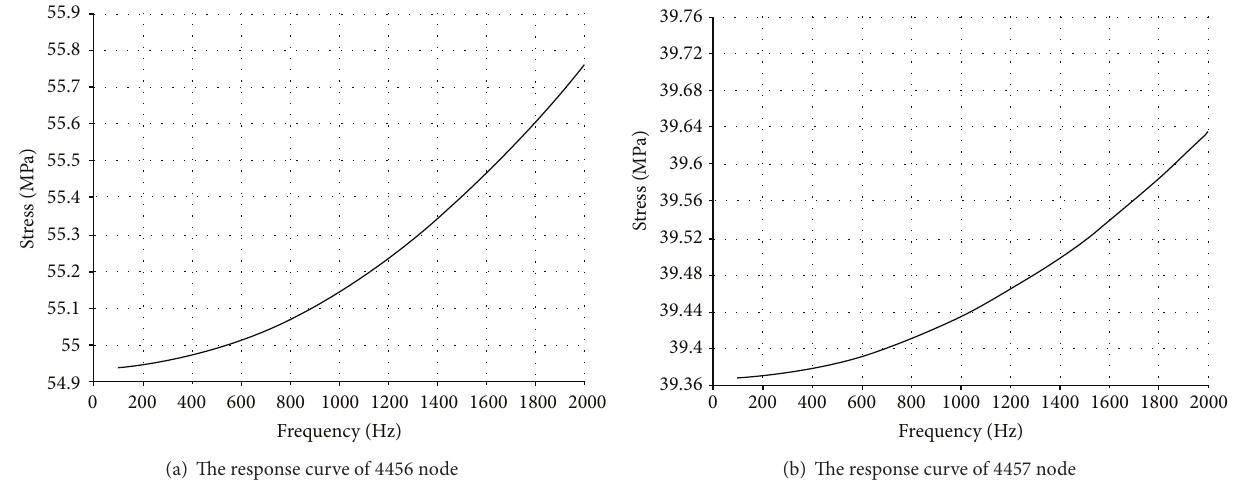
Figure 6: The displacement response curve of 0.5 mm.